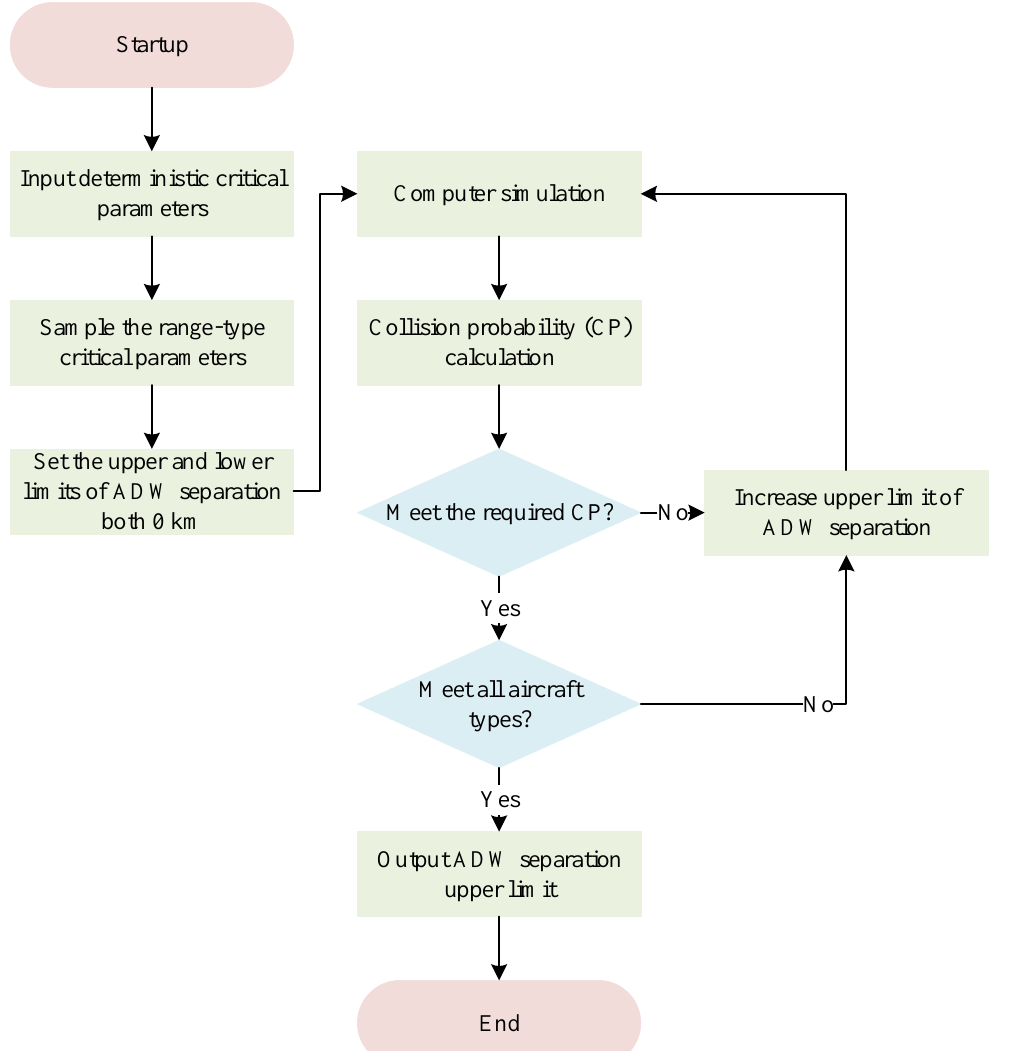
Figure 14. The calculation flowchart of the upper limit of the ADW